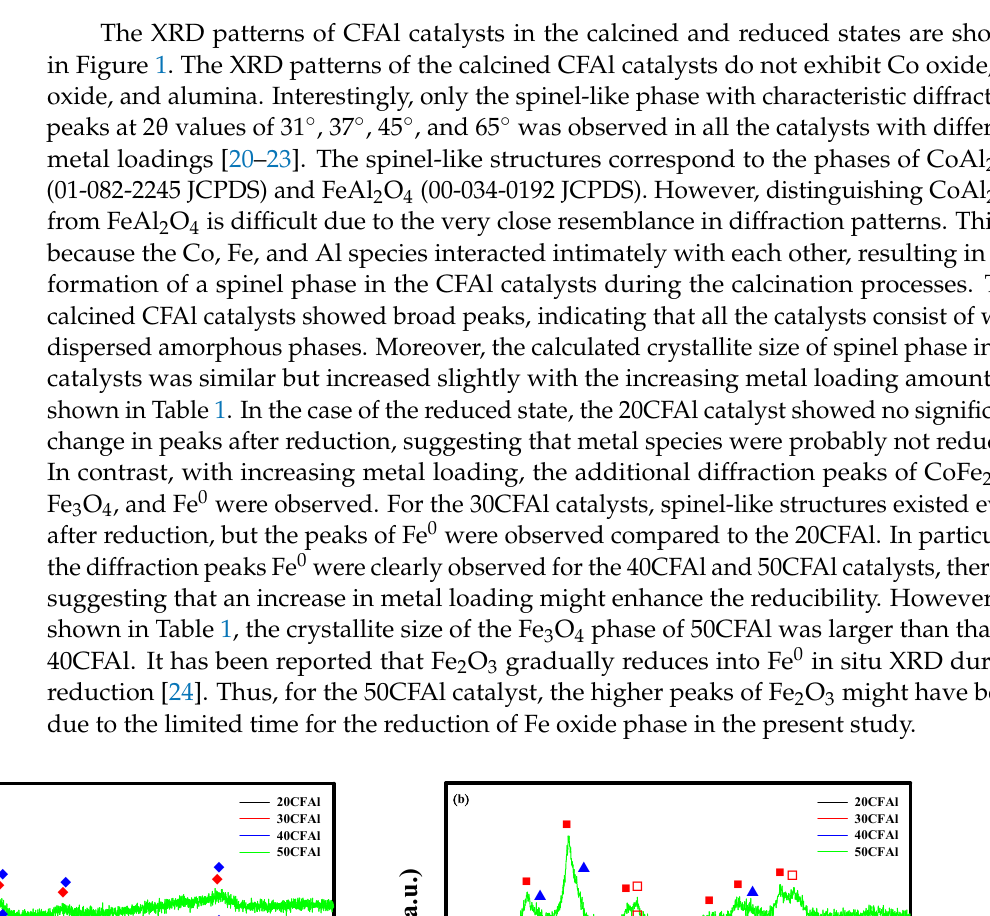
Table 1. Characterization of the CFAl catalysts with different metal loadings.